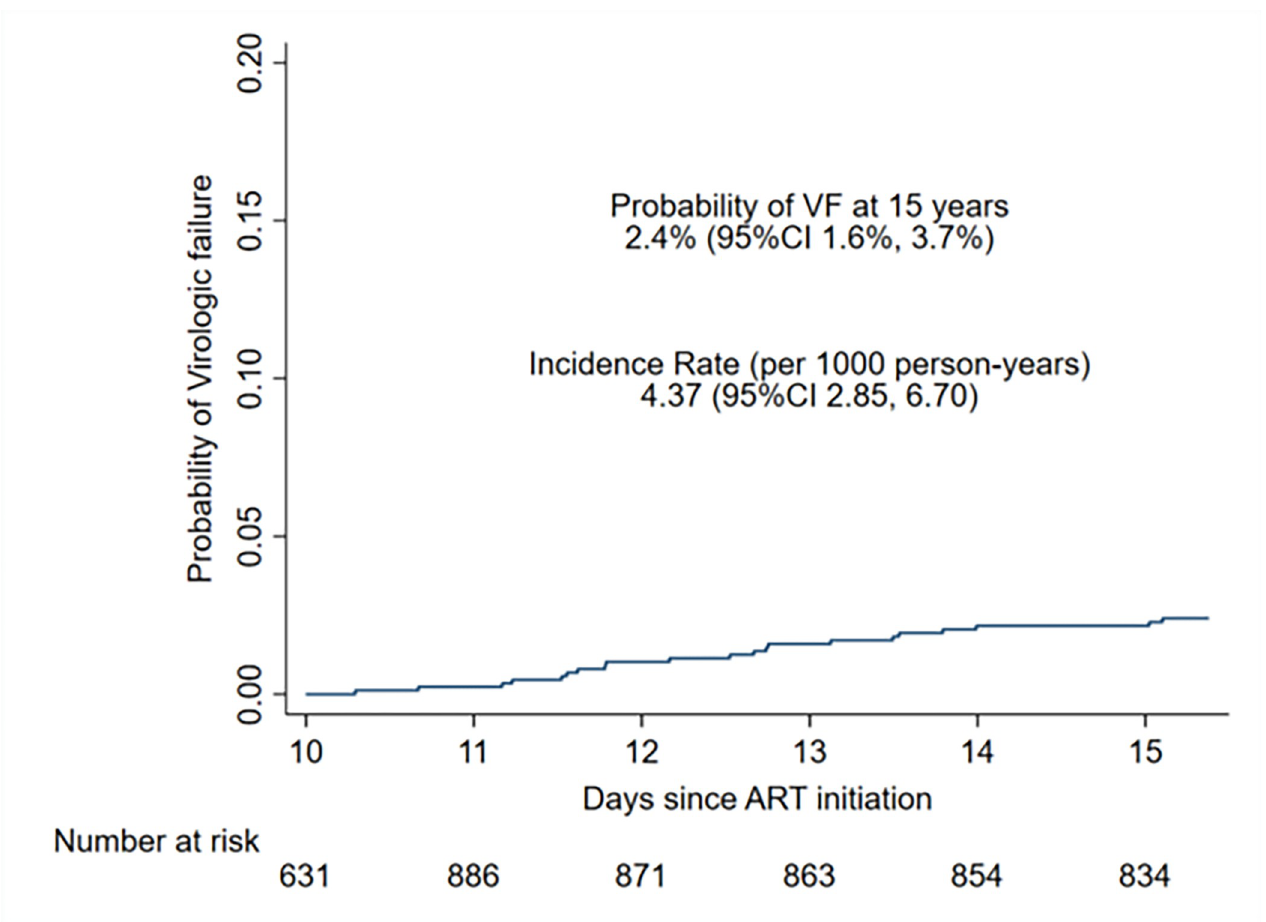
Fig 2. Probability and incidence rate of virological failure among persons on long-term ART. Kaplan-Meier indicates the probability of virologic failure and incidence rate at 15 years of follow-up among long-term persons on ART.